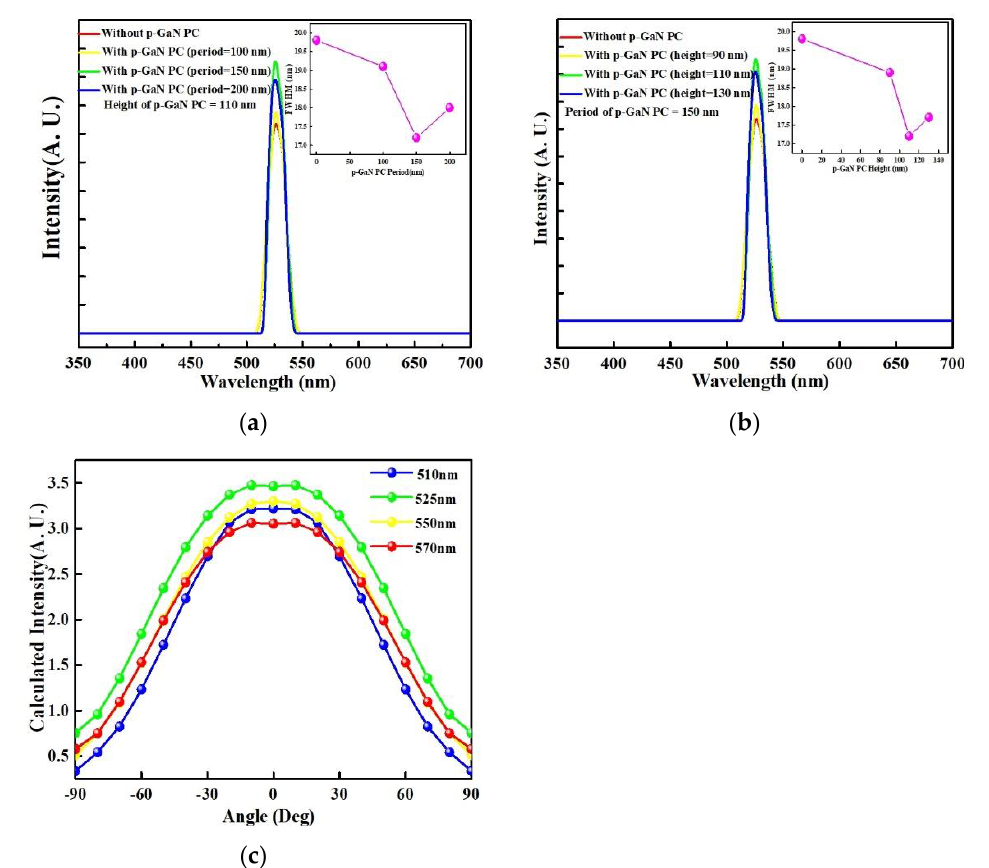
Figure 7. Electroluminescence spectra as a function of wavelength for the InGaN/GaN green LEDs without and with varied ( a ) period and ( b ) height of the PC-structured p-GaN nanorods. ( c ) The calculated intensity of InGaN/GaN green LEDs with the optimal PC-structured p-GaN nanorods at 510, 525, 550, and 570 nm.